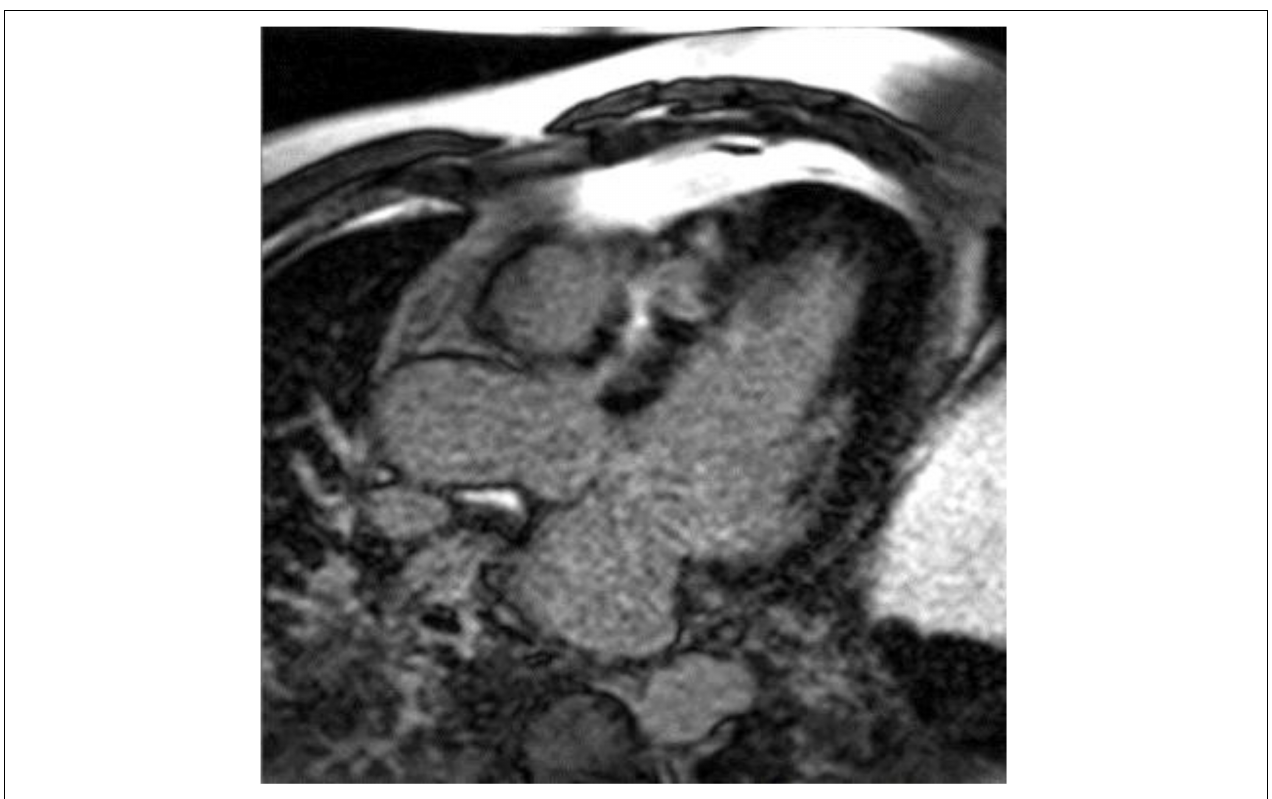
FIGURE 4 | Late gadolinium enhancement (LGE) image from a cardiac magnetic resonance image in the three-chamber view showing significant fibrosis in the anteroseptum of a patient with hypertrophic cardiomyopathy. Image courtesy Arlene Sirajuddin,